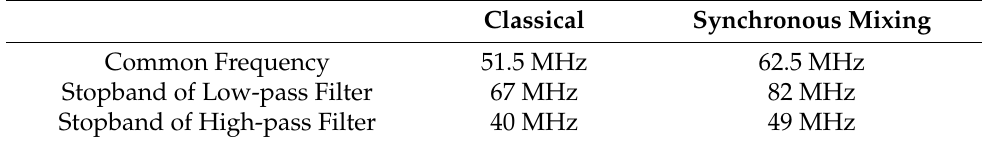
Figure 10. Structure of the diplexer. Table 1. Key specifications for input